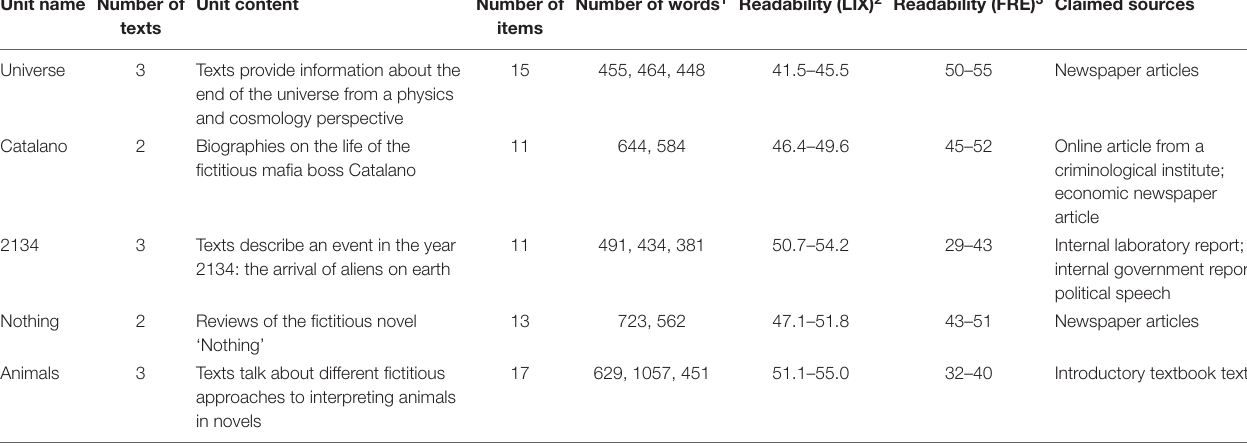
TABLE 1 | Text characteristics of the MDC